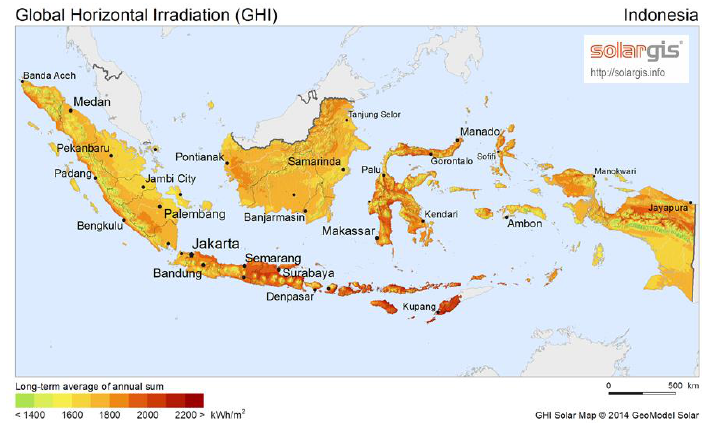
Fig. 10. Global Horizontal Irradiation (GHI) of Surabaya, Indonesia [21].